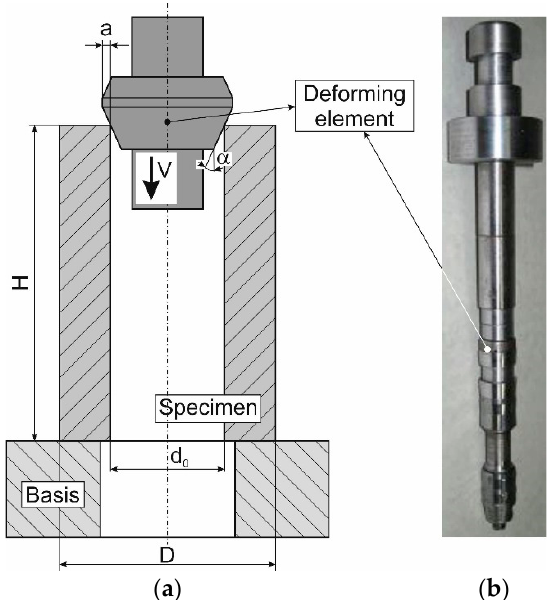
Figure 4. Deforming broaching: ( a )—process scheme; ( b )—deforming broach ( α -generatrix inclination angle of the working cone).